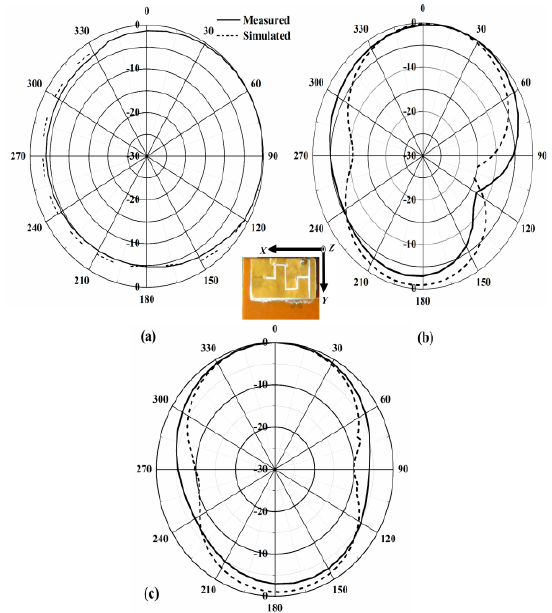
Figure 9: Measured and simulated 2-D principal plane pattern of the proposed antenna at 0.9 GHz (a) x-z plane (b) y-z plane (c) x-y plane.